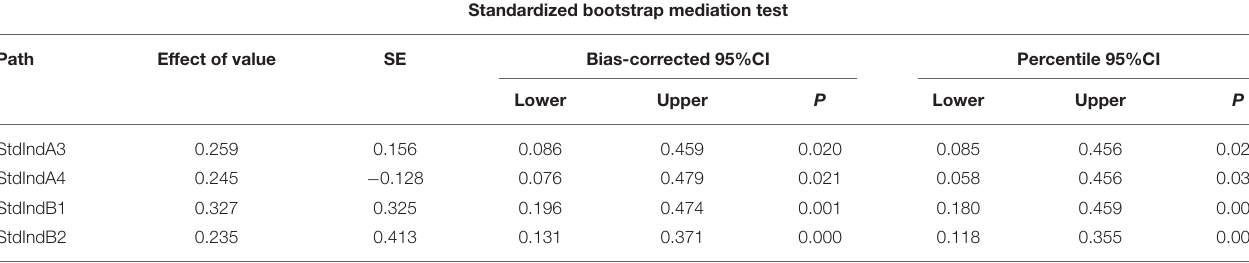
TABLE 7 | Modified full-path path coefficient and significance test.